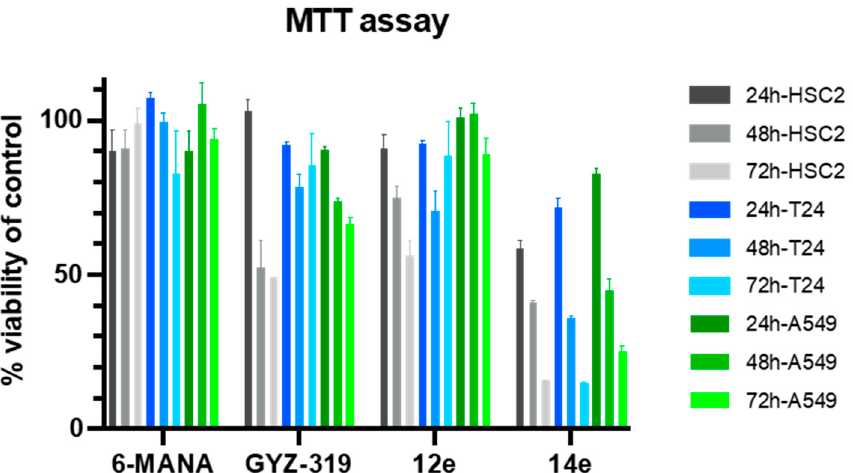
Figure 3. Results of the 3-(4,5-dimethylthiazol-2-yl)-2,5-diphenyl tetrazolium bromide (MTT) cell viability assay on HSC-2 human oral cancer (grey), T24 human bladder cancer (blue), and A549 human lung cancer cells (green) with compounds 6-methylaminonicotinamide (6-MANA), parent compound GYZ-319, and prodrugs 12e and 14e. Compounds were incubated for 24, 48, and 72 h at 1, 10, and 100 µM concentrations. As no effects were observed at 1 and 10 µM, only results at 100 µM are depicted. Results are presented as mean values with standard deviation from three independent experiments performed in triplicate.